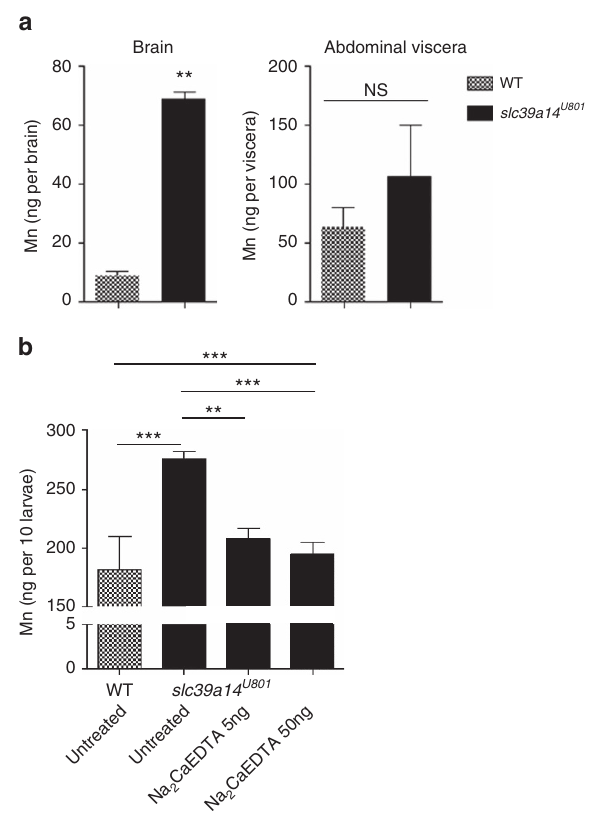
Figure 7 | Mn accumulates in the brain of s lc39a14 U801 mutants and can be lowered by Na 2 CaEDTA. ( a ) Tissue Mn levels of wild-type (WT) and homozygous s lc39a14 U801 zebrafish at 1 year of age show that mutant brain tissue accumulates significantly higher amounts of Mn ( P ¼ 0.0012) while no differences are evident in the Mn content of abdominal viscera ( P ¼ 0.116). Measurements were taken from pools of four brains/ abdominal viscera. Data are presented as means ± s.d. from two independent experiments. Statistical analysis was performed using Student’s two-tailed t -test (** P o 0.01; NS, not significant). ( b ) Graph showing the effect of Na 2 CaEDTA injections on Mn levels in homozygous s lc39a14 U801 larvae. Mutant larvae exposed to 50 m M MnCl 2 from 2 to 5 dpf were injected into the heart with 5 or 50ng of Na 2 CaEDTA at 2, 3 and 4 dpf, resulting in a reduction of Mn levels to that of wild-type larvae ( P ¼ 0.000 (WT untreated versus mutant untreated), P ¼ 0.001 (mutant untreated versus 5ng), P ¼ 0.001 (mutant untreated versus 50ng)). Measurements were taken from pools of 10 larvae. Data are presented as means ± s.d. from a minimum of three independent experiments. Statistical analysis was performed using one-way ANOVA ( P ¼ 0.000) and Tukey’s multiple comparison test (** P o 0.01, *** P o 0.001). ANOVA, analysis of